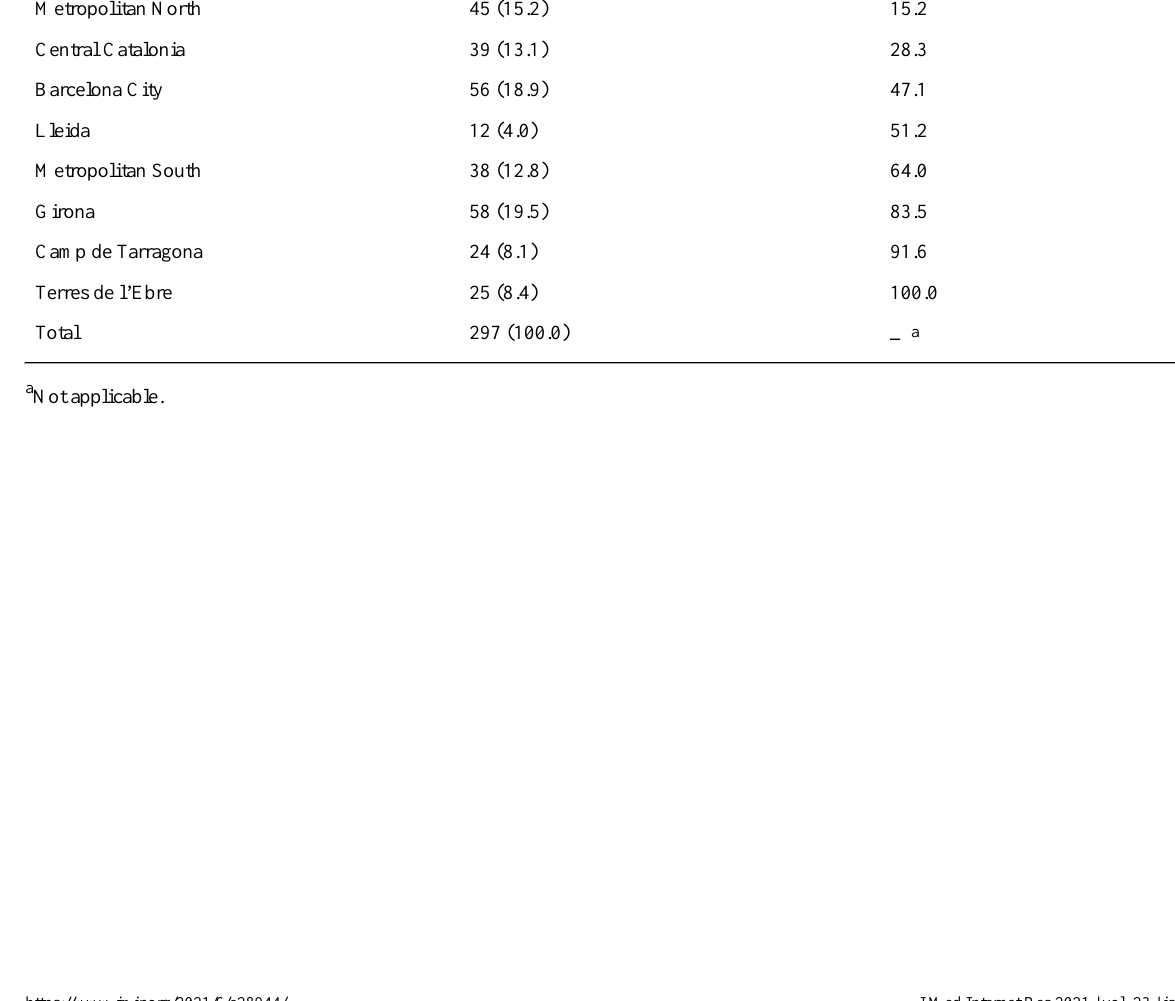
Family nursesGeneral practitionersOverall modelVariable